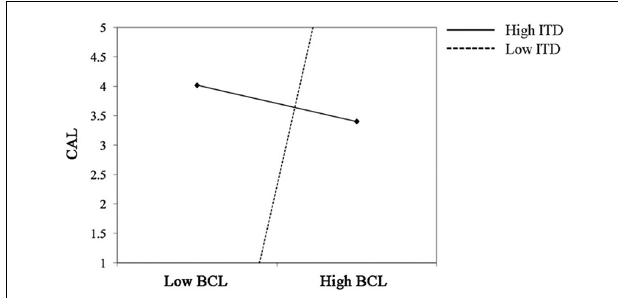
FIGURE 4 | Interaction between BCL and ITD on CAL.